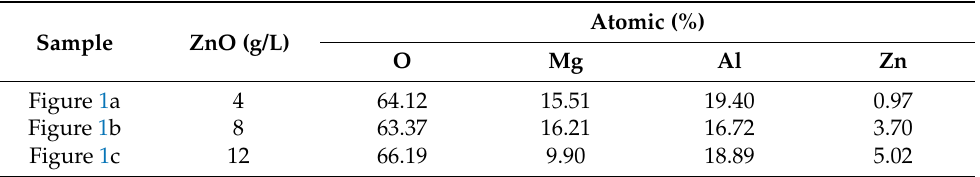
Table 1. EDS analysis of coatings in Figure 4b.